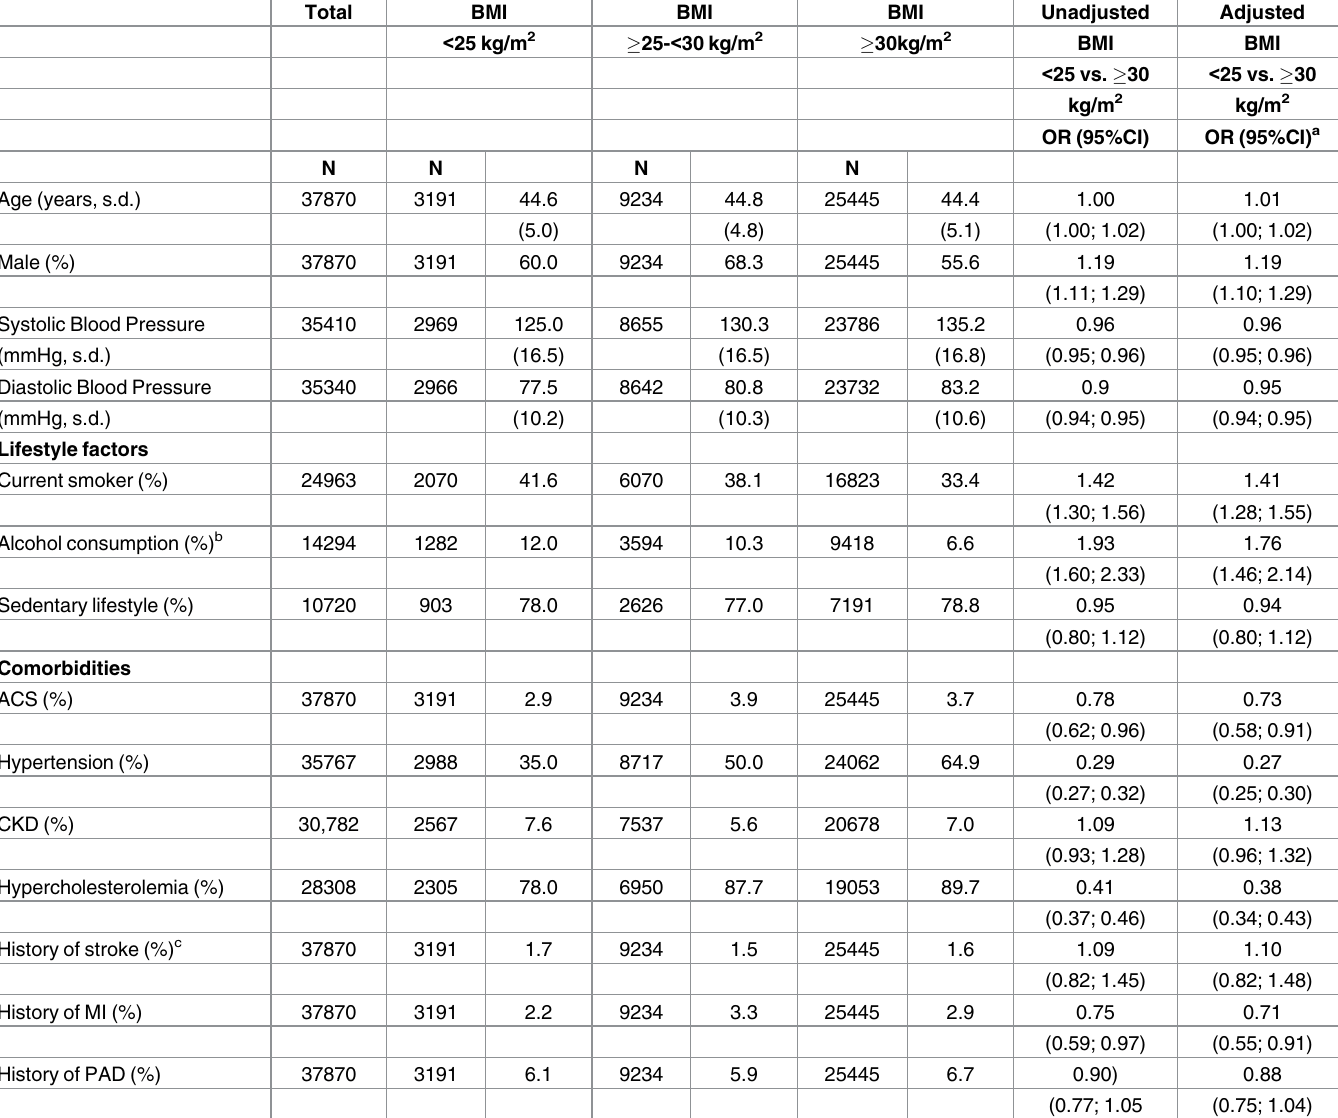
Table 1. Patient characteristics and multivariable adjusted “predictors” for participants with lean type 2 diabetes (BMI < 25kg/m 2 ) vs. participants with BMI (cid:21) 30 kg/m 2 . Total